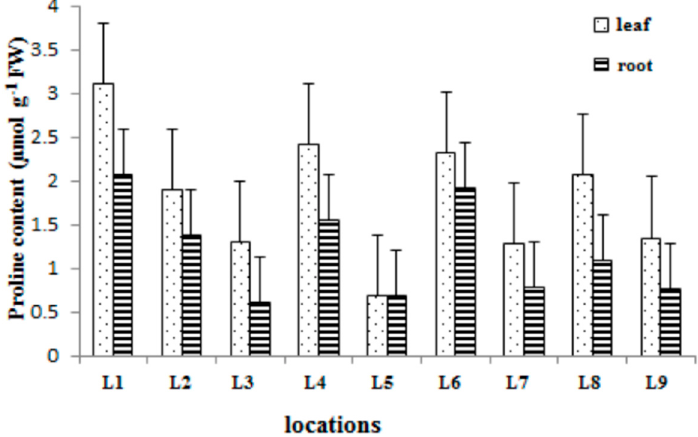
Figure 4. Proline accumulation in the leaf and the root of Trapa natans L. sampled from di ff erent locations.